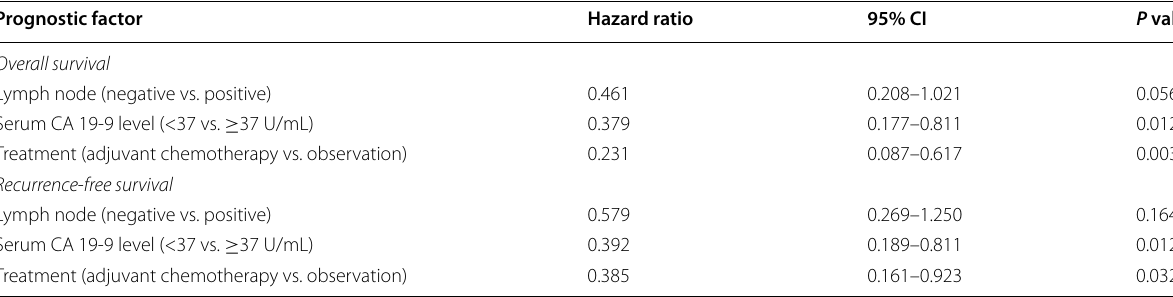
Baseline CA 19-9 levels were unavailable for 12 patients in the adjuvant chemotherapy group and 15 patients in the observation group b Seven patients in the adjuvant chemotherapy group and 2 patients in the observation group had unspecified carcinoma Table 4 Multivariate analysis of survival in patients with stages II and III BTC